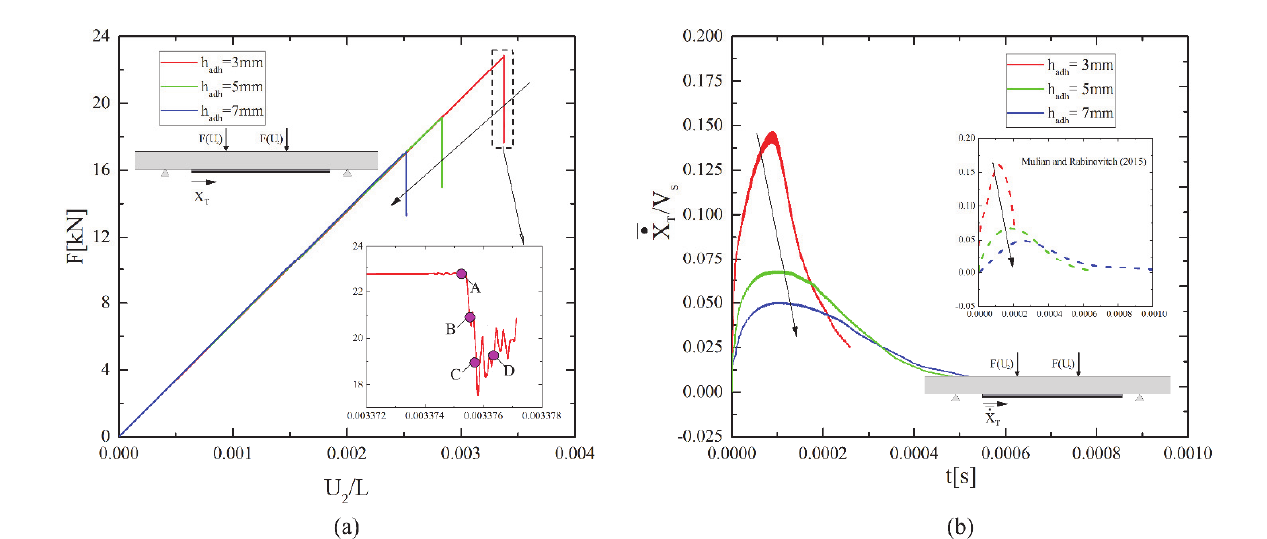
Figure 8: Comparisons in terms of loading curve for different thicknesses of the adhesive layer (a); Comparisons in terms of time histories of the debonding front speed for different thickness of the adhesive layer